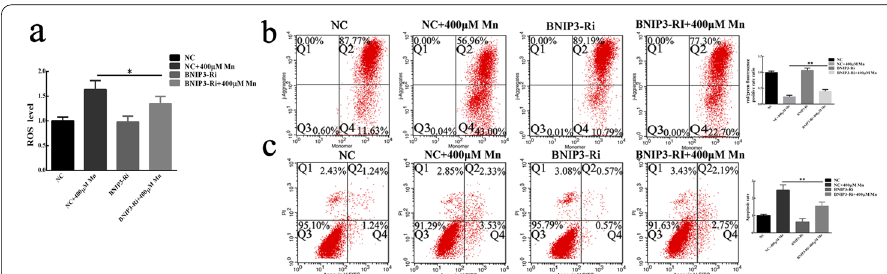
Fig. 5 BNIP3 mediated MnCl 2 -induced ROS generation and neurotoxicity. a , b , c After treatment with or without 400 µM MnCl 2 , the levels of ROS ( a ), the mitochondrial membrane potential ( b ), and cell apoptosis ( c ) were assessed in cells with or without BNIP3 shRNA lentivirus. NC, negative control treatment. NC treated with 400 µM MnCl 2 but not treated with lentivirus carrying interference sequences at 24 h. BNIP3-Ri, BNIP3 shRNA-transfected cells. BNIP3-Ri Mn, cells treated with 400 µM MnCl 2 and transfected with BNIP3 + shRNA at 24